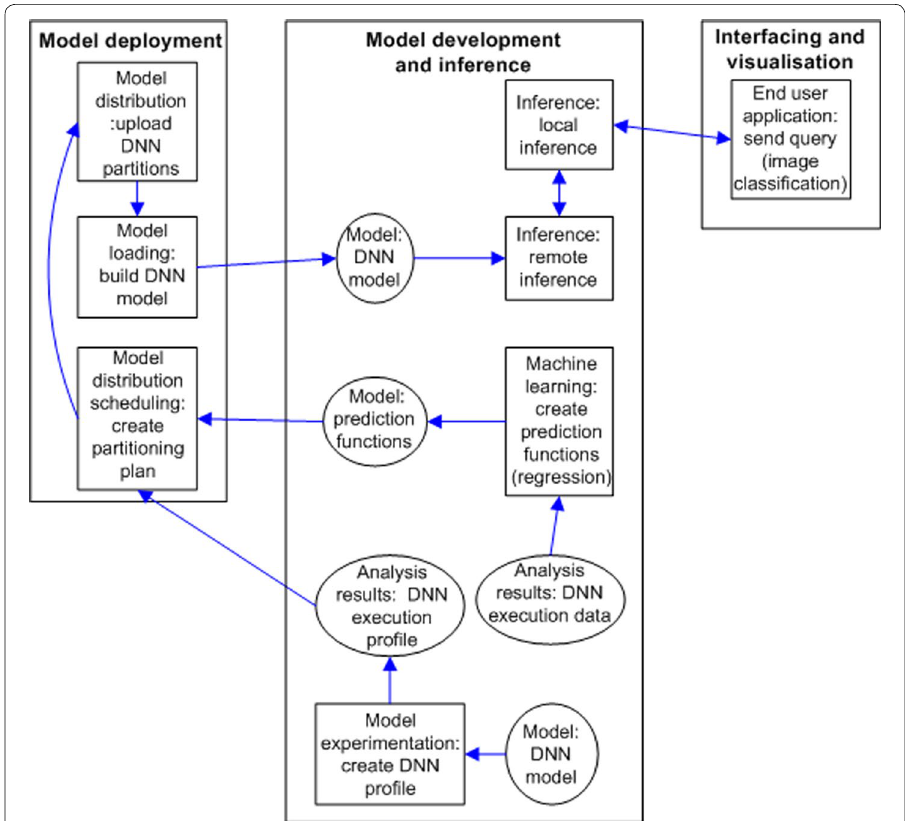
Fig. 9 The mapping of incremental offloading of NN computations [28] to the big data